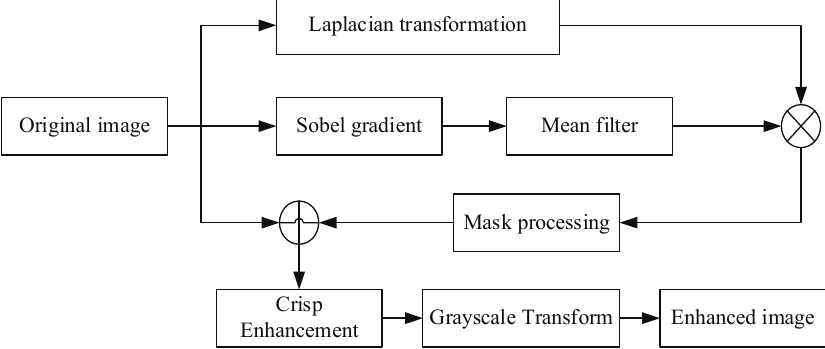
Figure 3. The image enhancement flow diagram of the jet trajectory original